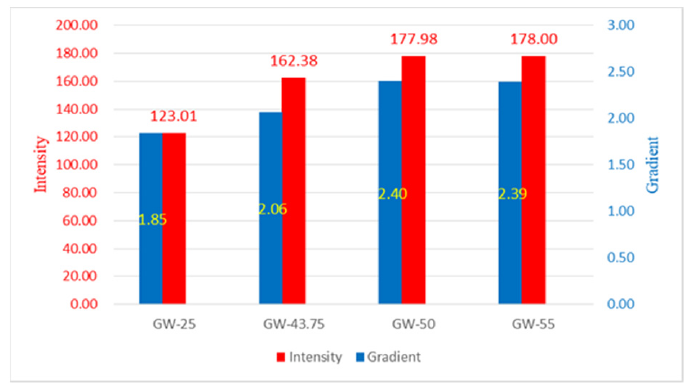
Figure 10. Performance of different GW in MSI method.